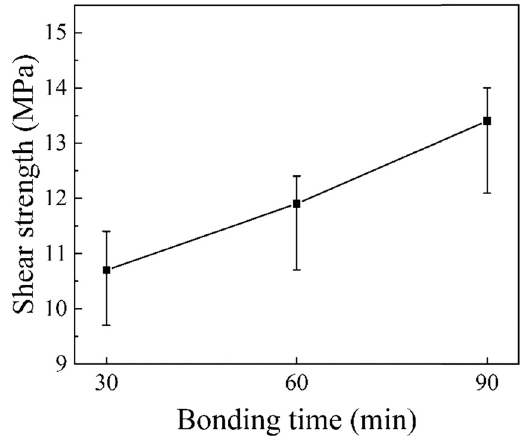
Figure 5: E ff ect of bonding time on the shear strength of graphite/Cu